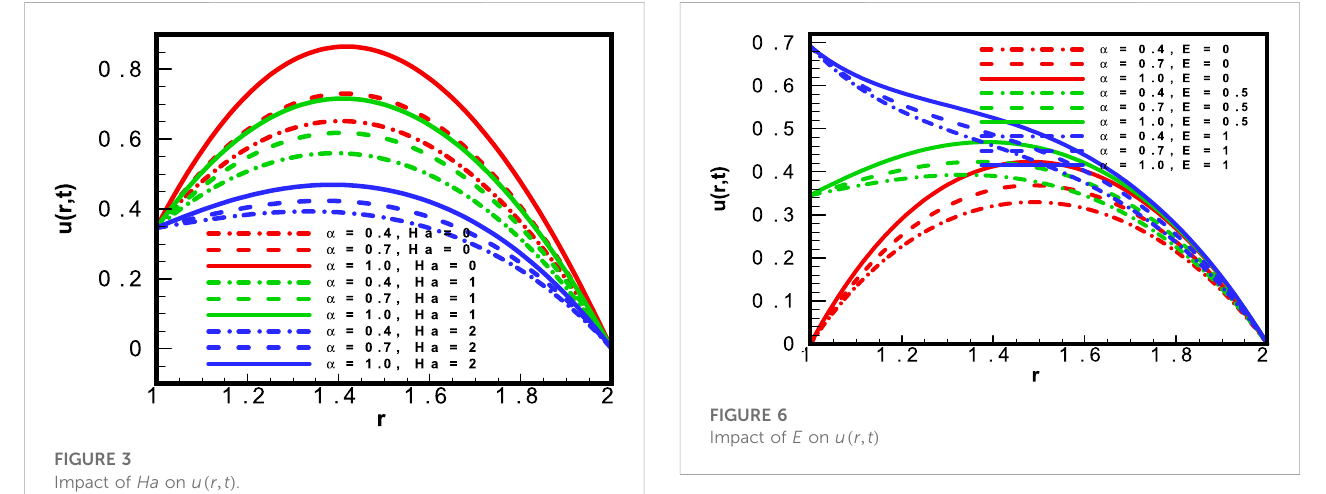
FIGURE 3 Impact of Ha on u ( r , t ) .